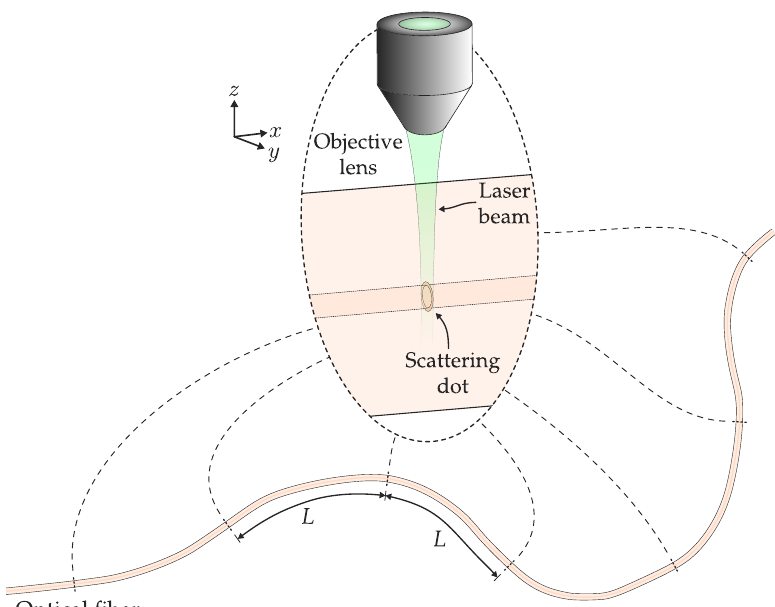
Figure 16. Illustrative diagram of several weak reflectors (scattering dots) located within an optical fiber, and equally spaced distance L between each pair. The refractive index changes have been generated from the tight focusing of femtosecond laser